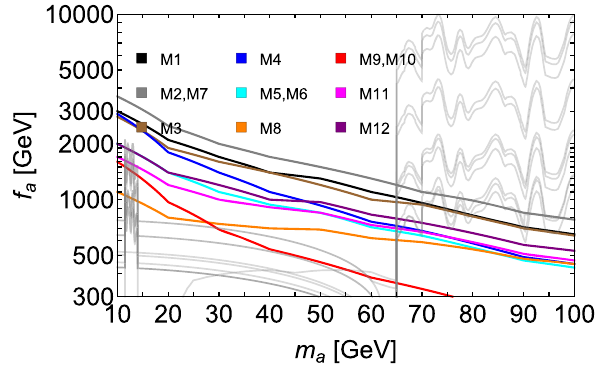
Fig. 2 Values of f a for models M1 - M12 for which Z ≡ √ S / B + δ 2 B 2 = 3 in the proposed di-tau search after an integrated Luminosity of 300 fb − 1 . We assume a systematic error on the back- ground δ = 1%. Shown in grey are the current bounds as of Fig. 1